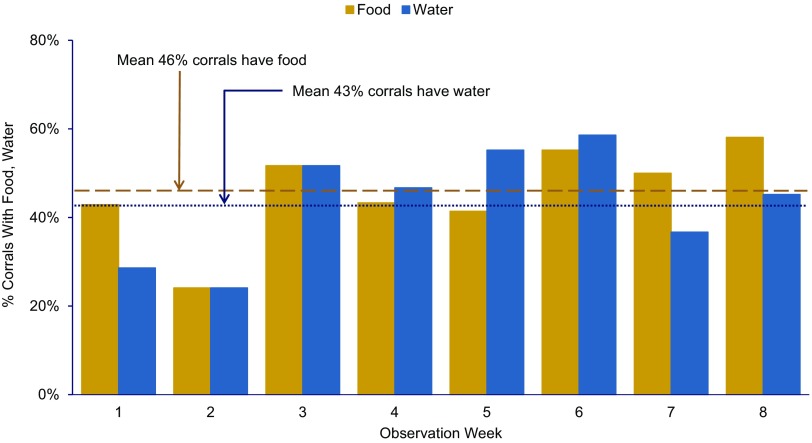
Percentage of Domestic Poultry Corrals Containing Food or Water During Weekly Random Observations, Lima, Peru (N=122 Observations)